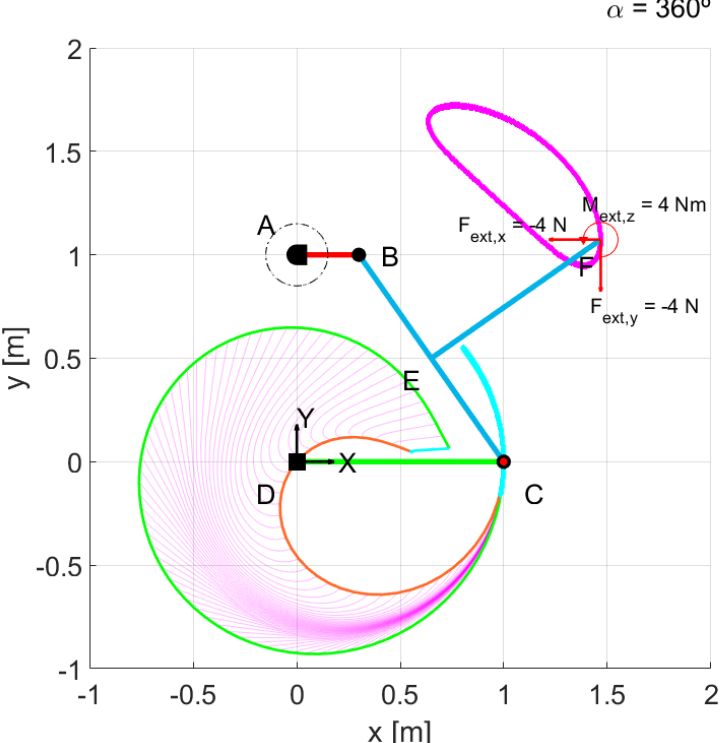
Figure 18. First mechanism circuit under external loading of F ext , x = − 4 N, F ext , y = − 4 N, and M ext , z = 4 Nm. Final position and